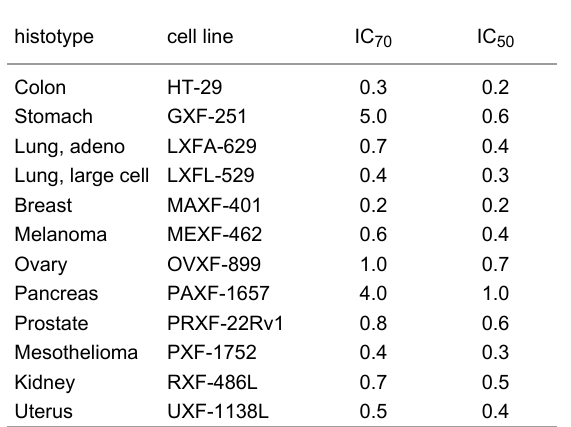
Table 1: Cytotoxicities (IC 70 , IC 50 , nM) of malevamide D ( 1 ) against selected human cancer cell lines.